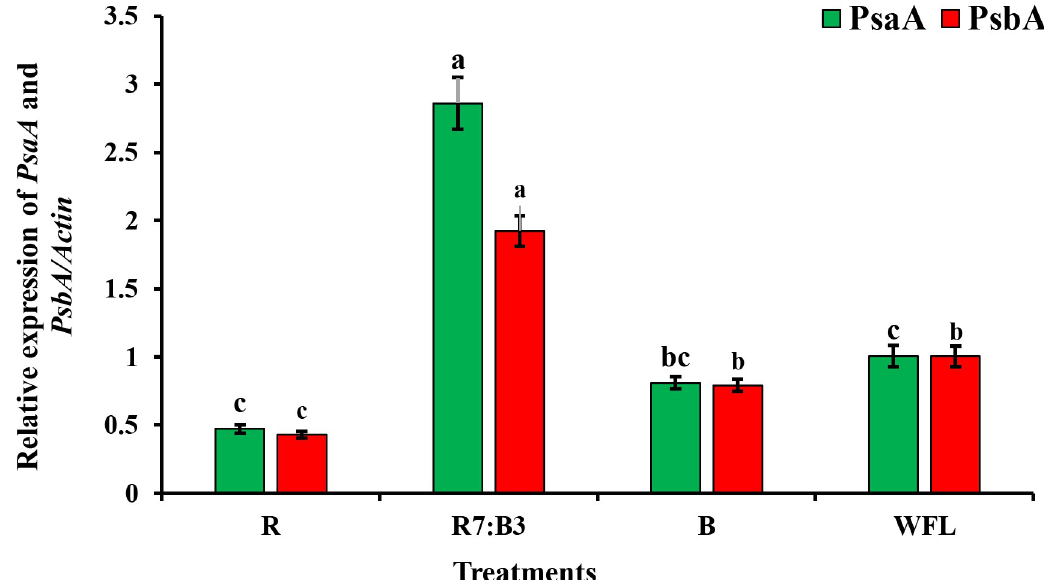
Fig 7. The relative expressions of PsaA and PsbA in leaves of grafted tomato seedlings. According to DMRT, significant differences among treatments indicate the average ± standard error (P � 0.05) of three technical replicates (n = 4). Where R = Red light 100%, R7:B3 = Red70%+ Blue30%, B = Blue light 100%, WFL = White Fluorescent